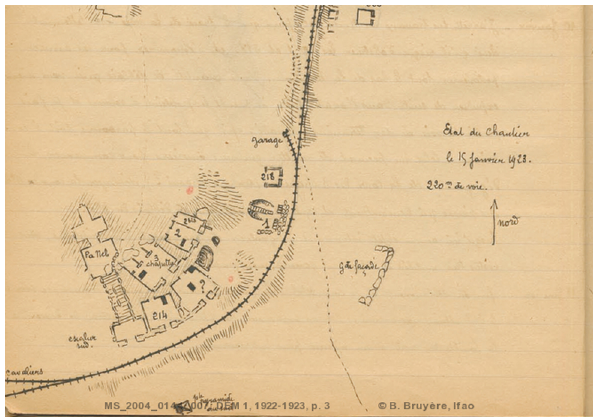
Figure 3 . One of the sketches by Bruyère (Bruyère’s Notebook, opposite to entry of 12 January